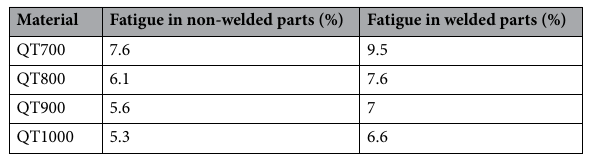
Table 11. Fatigue damage comparison for CTs in relation to HOC job at 2000 psi circulation pressure.